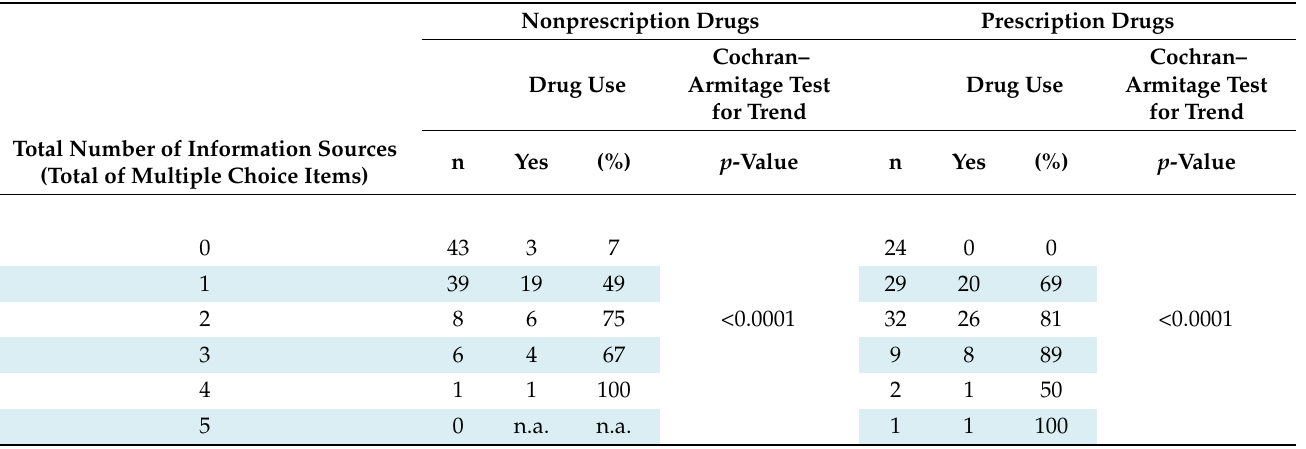
Table 5. Total number of drug information sources in the breastfeeding group (n =